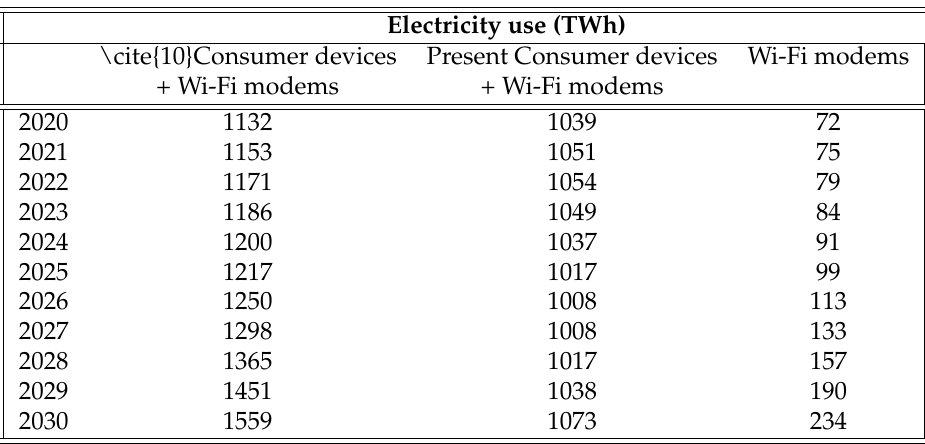
Table 5. Differences between [3] expected case and the present prediction for devices use stage electric power